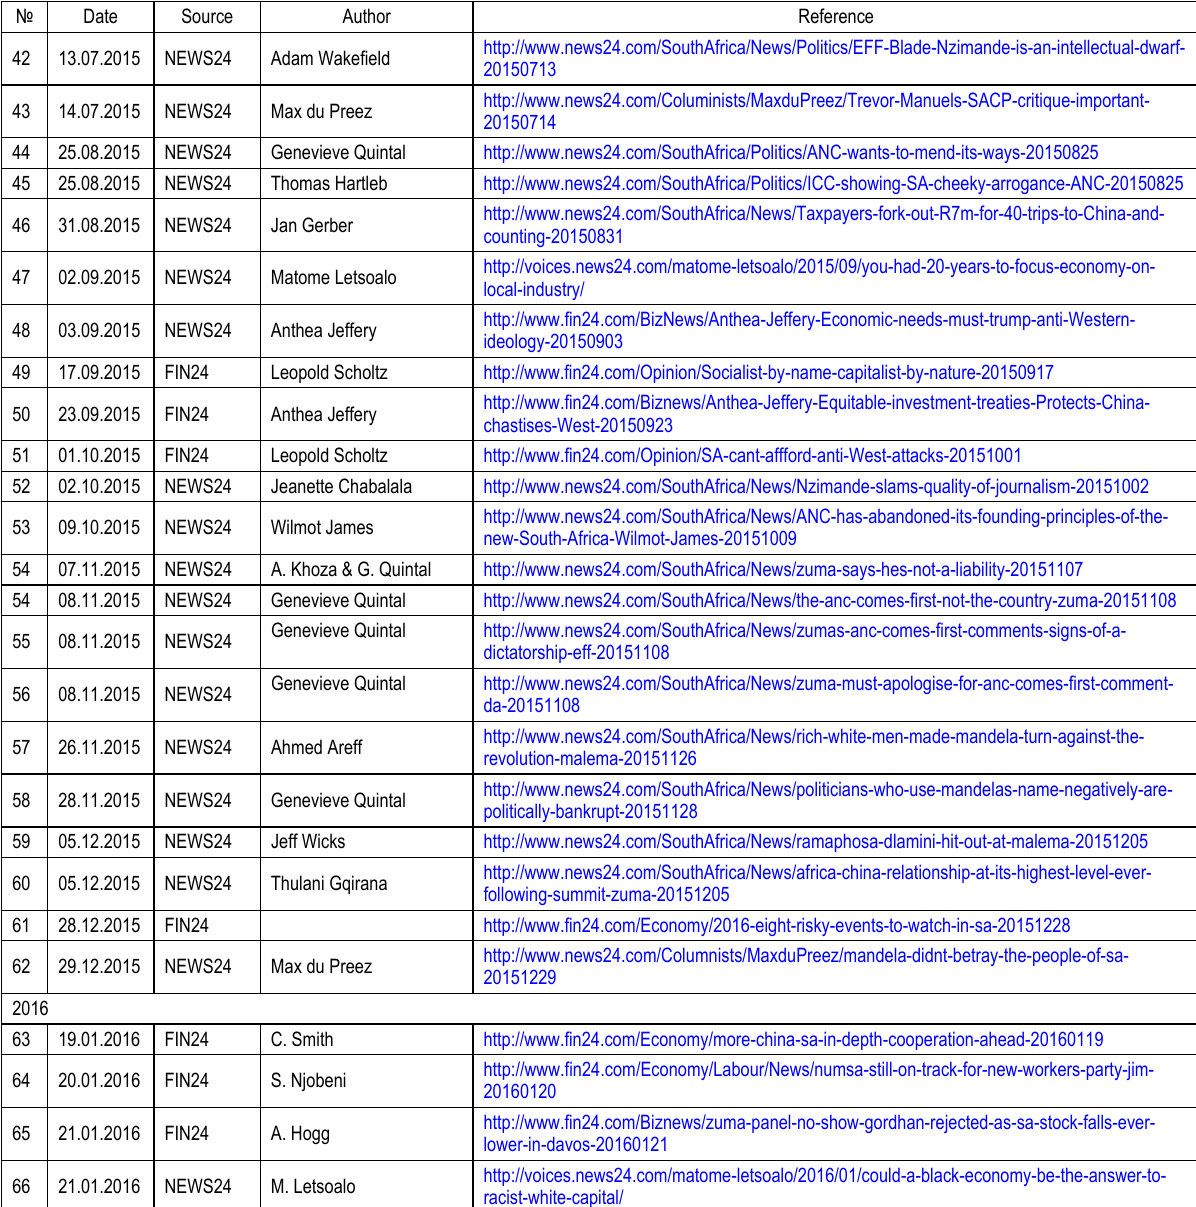
Table 2 (references) (cont.). Movement towards socialism/communism of BEE (January 2014-January